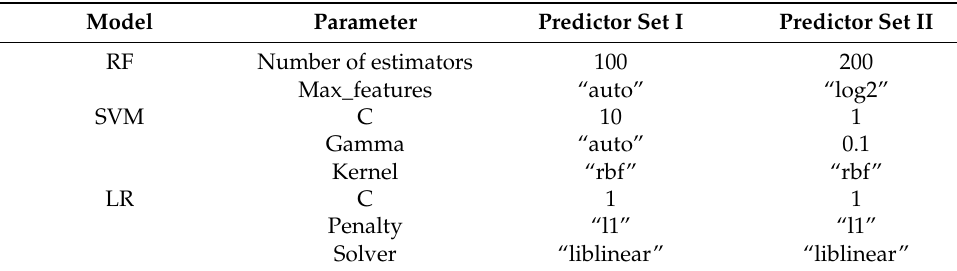
Table 5. Hyperparameters used in the ML